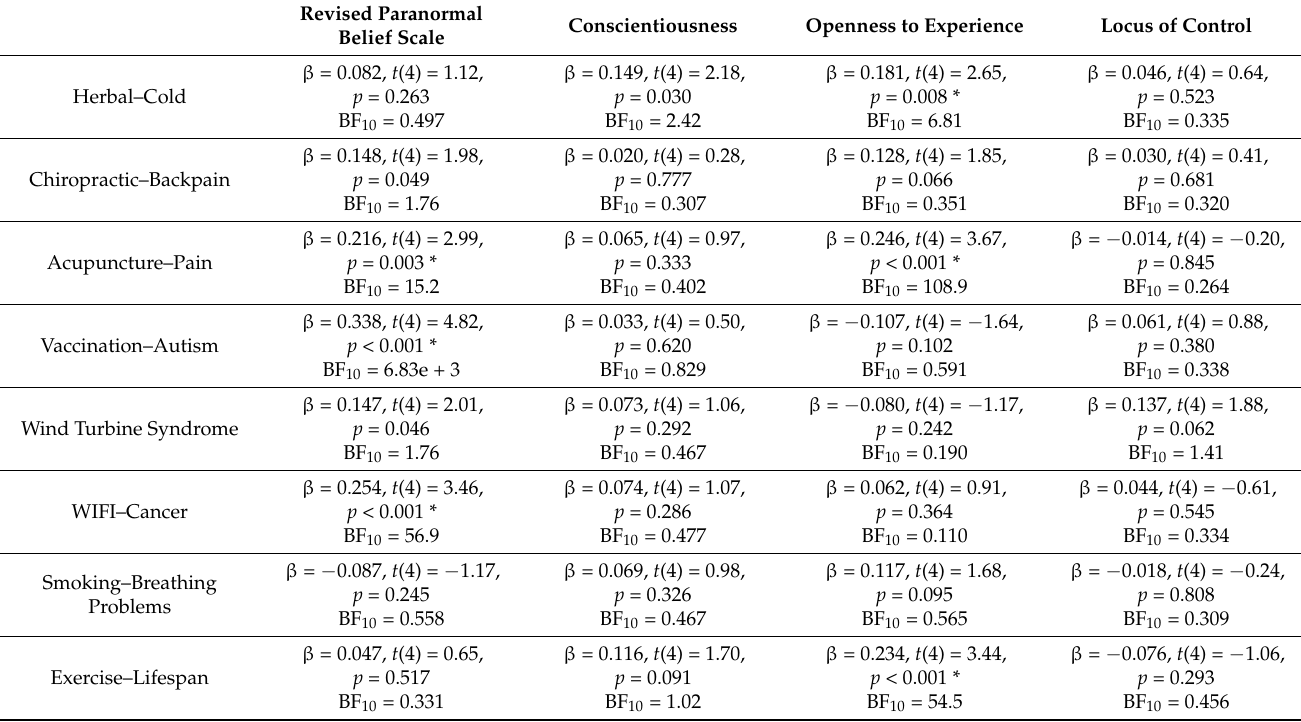
Table 3. Summary statistics of the relationship between the four personality variables measured at the end of the survey (re- vised paranormal belief scale, measures of openness to experience and conscientiousness, and Levenson’s multidimensional locus of control scale) on causal